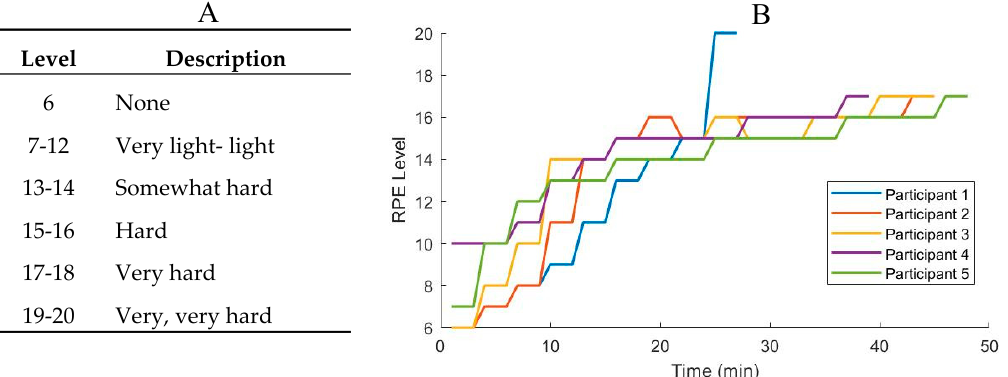
Figure 2. ( A ) Description of levels of Borg Rating of Perceived Exertion (RPE) scale and ( B ) changes in the Borg RPE of each participant during the